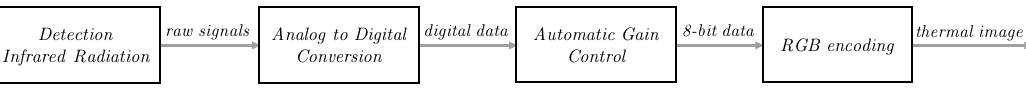
Figure 1. High-level diagram of the process flow in uncooled microbolometer